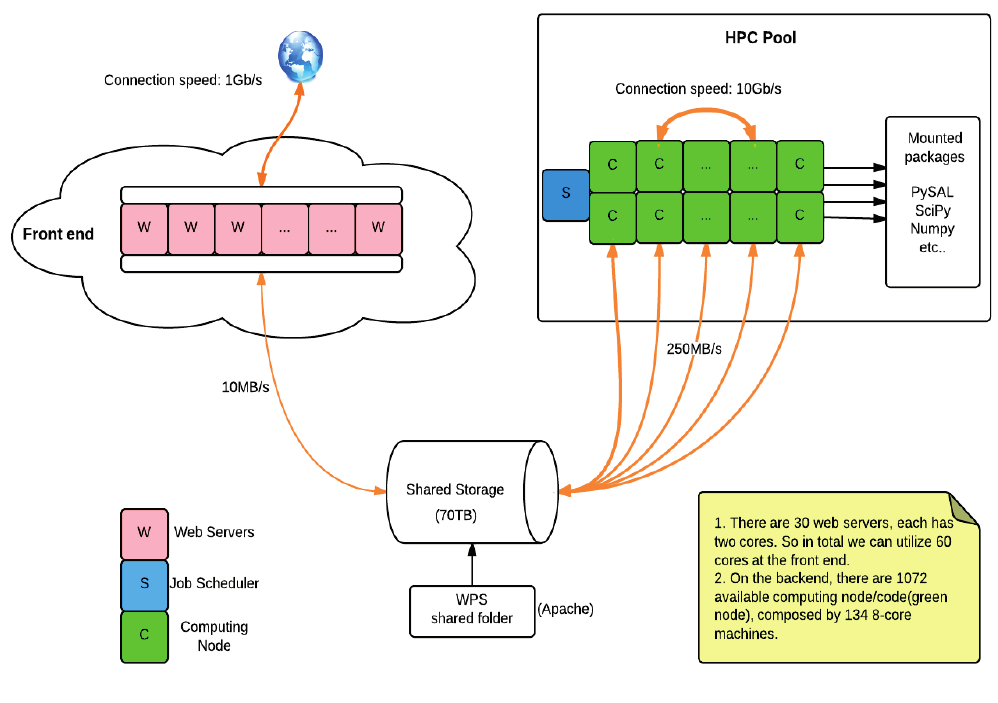
Figure 11. Complex systems framework components.